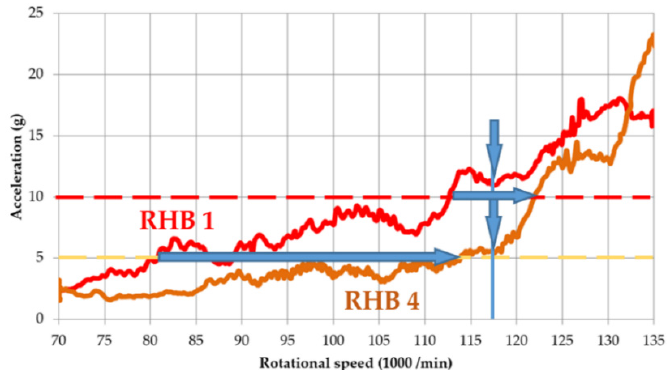
Figure 7. Comparison of vibration acceleration for RHBs 1 and 4 for excitation above 10 g.